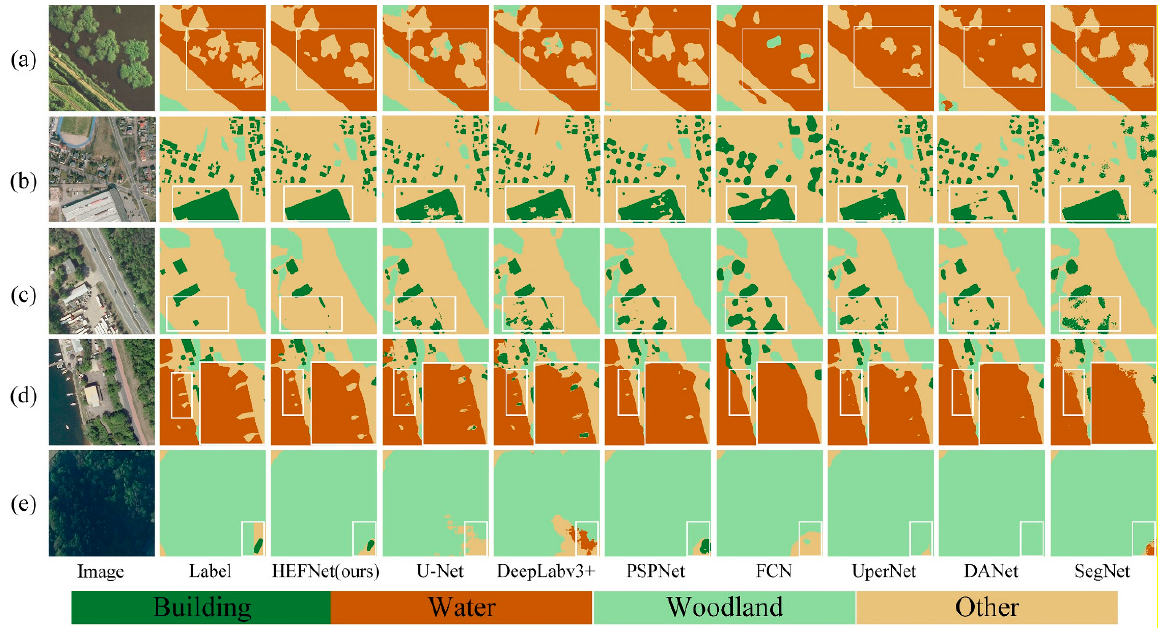
Figure 11. Visual comparison of classification results of the state-of-the-art models on the landcover.ai. ( a ) shows the case of inaccurate identification of object outlines, ( b ) shows the case of incomplete large-scale objects identification under multi-scale environment, ( c ) shows the case of the phenomenon of foreign objects in the same spectrum causing false identification. ( d , e ) shows the typical cases that small-scale objects are difficult to be identified.